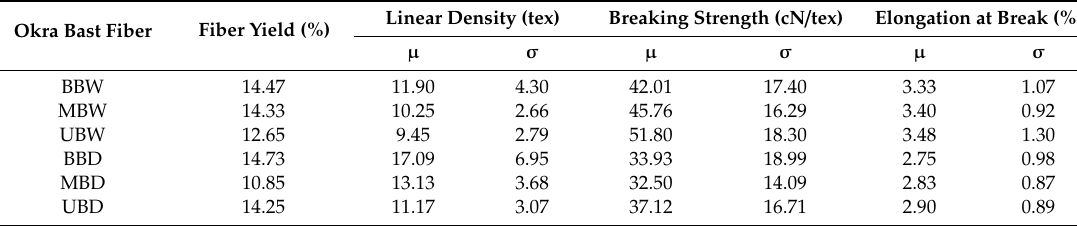
Table 2. The e ff ect of extracted plant part and retting method on the physical and mechanical properties of okra bast